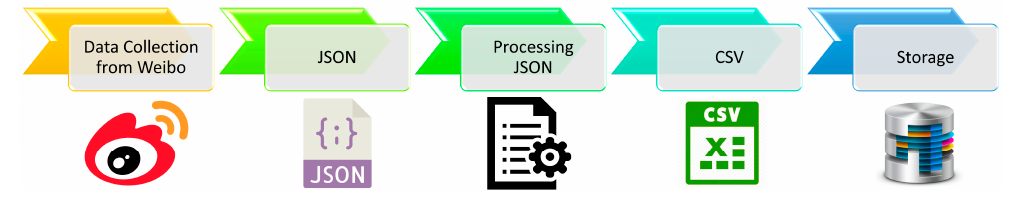
Figure 2. Process flow of data preparation.